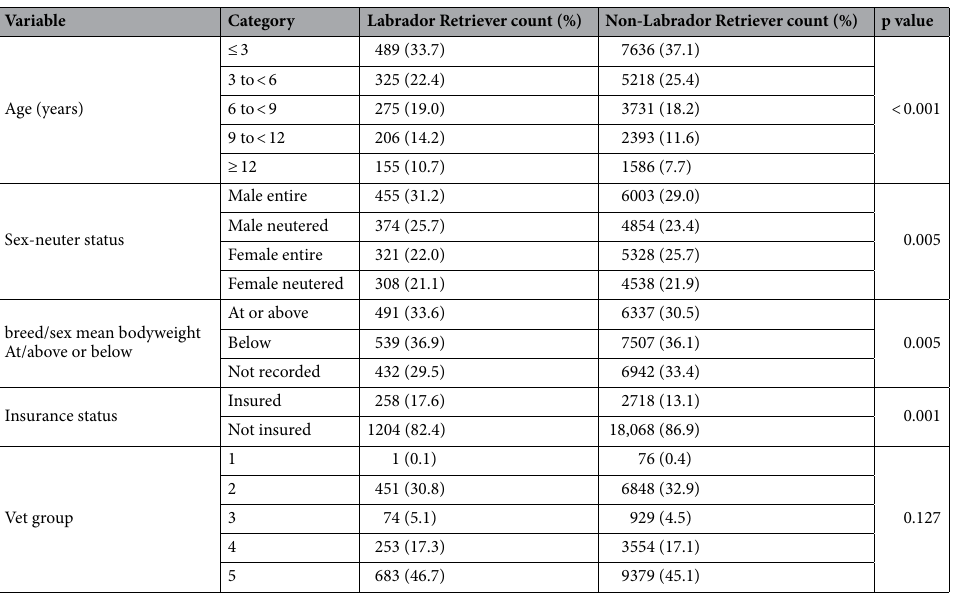
Table 1. Descriptive statistics for demographic characteristics in Labrador Retrievers (n = 1462) and non- Labrador Retrievers (n = 20,786) under primary veterinary care in the UK. The p value represents comparison of demographic variables between Labrador Retrievers and non-Labrador Retrievers. Missing data were not included unless it accounted for a significant proportion of the variable (>